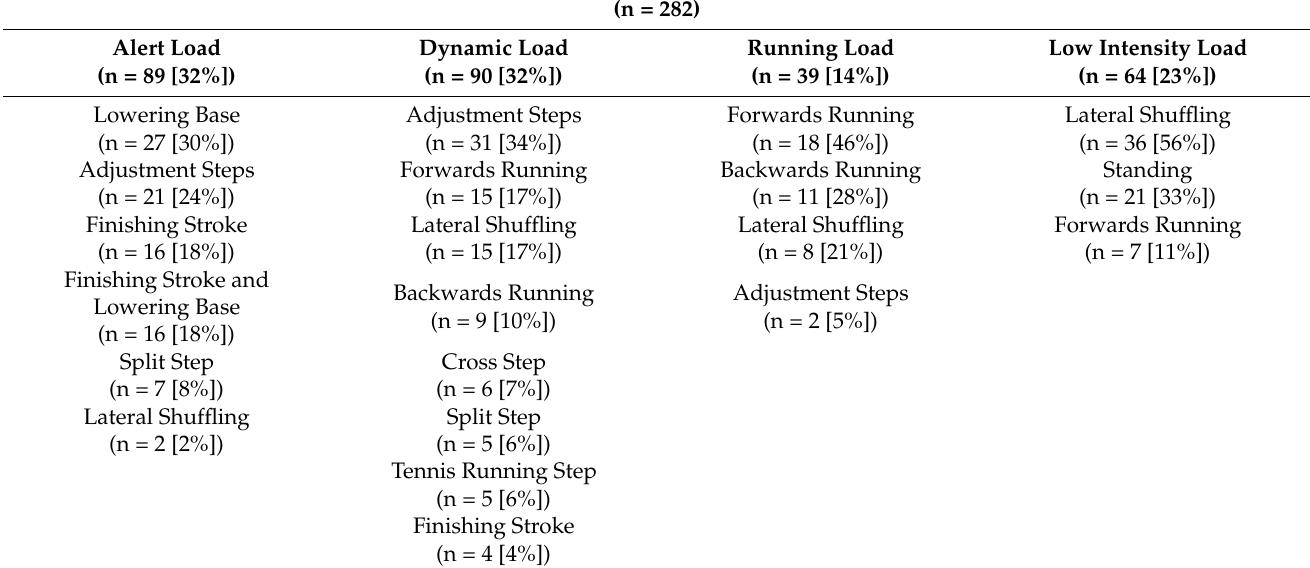
Table 5. Occurrence of manually coded movements within the Catapult classifications during “simulated” and “natural” tennis movement protocols. “Simulated” movement protocol = (1) Small Square, (2) Big Square, (3) Forehand Pattern and (4) Volley Transition “Natural” movement protocol = (1) Gravity Split Step and Step-Down Forehand, (2) Split Step and Cross Step to Mogul Forehand, (3) Split Step and Cross Step to Arabesque Forehand, (4) Split Step to Drop Step and Defensive Forehand and (5) Off Forehand Transition Pattern